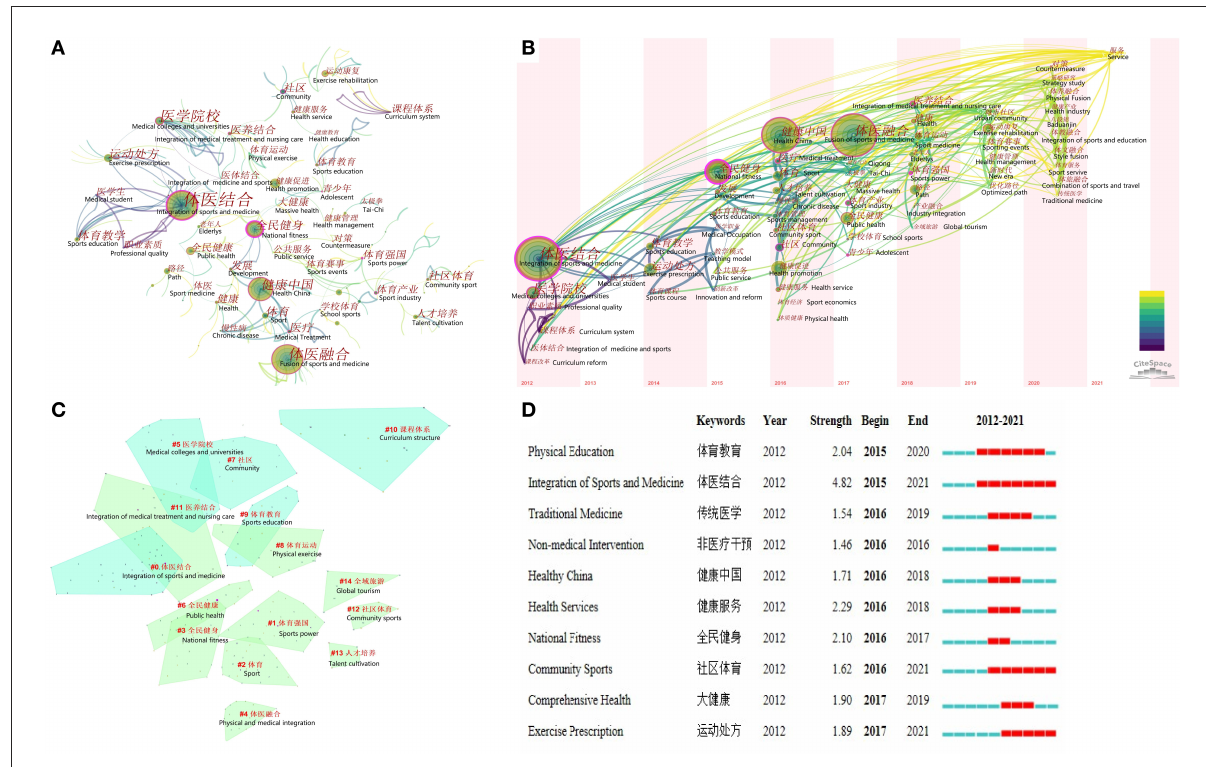
FIGURE4 Bibliometric analysis of the keywords. (A) The network map of keywords from publications on fusion of sports and medicine in China; (B) A timeline view of the network map of keywords; (C) The 15 keyword clusters produced by log-likelihood ratio; (D) Top 10 keywords with the strongest citation bursts. Each node represents a keyword, the bigger the node the keyword had more appearance in publications, the node with purple trims indicated a high betweenness centrality. The line indicated the relationship between keywords, the thicker the closer relationship, the lighter the later relationship were formed. The English was translated from the original figure yielded by